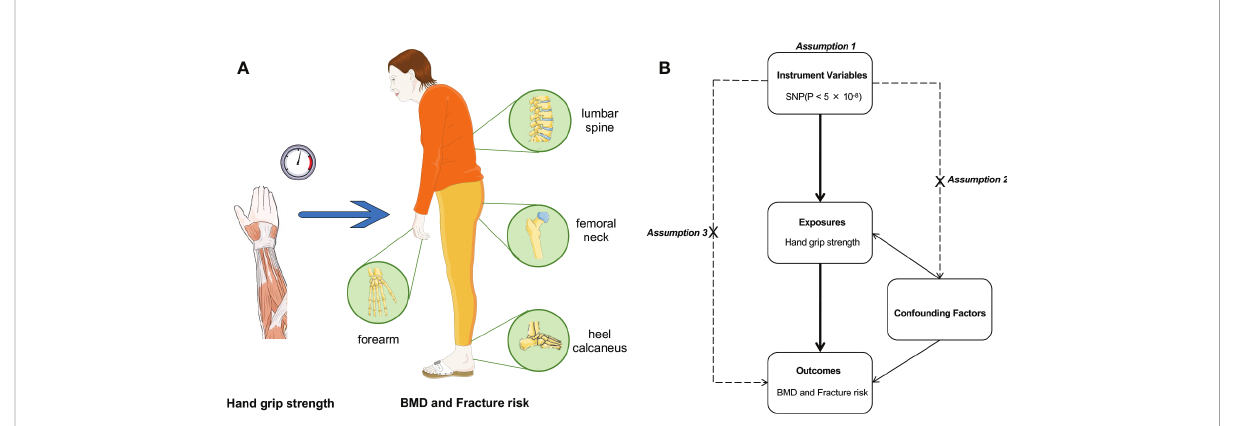
FIGURE 1 The study design of two ‐ sample MR analysis. (A) The schematic diagram of our study design. (B) Assumptions underlying a MR analysis. MR, Mendelian